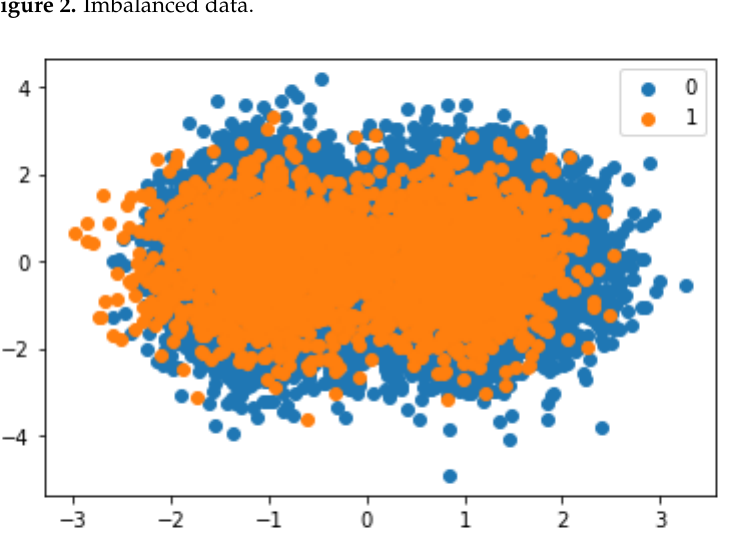
Figure 3. Balanced